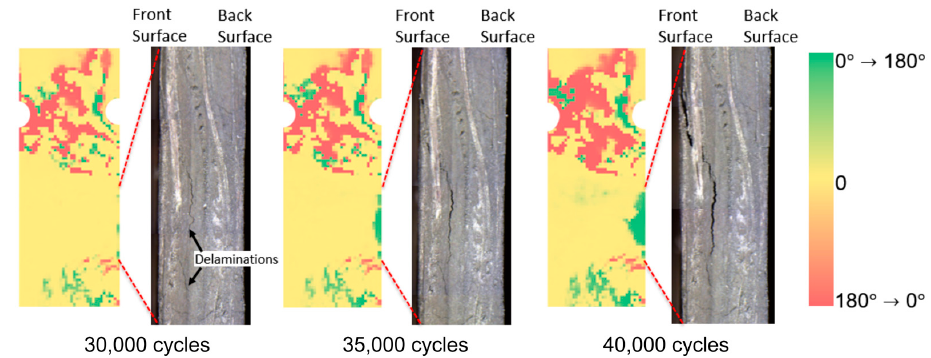
Figure 10. Microscopic visible images of specimen side surface indicating delamination damage evolution ( σ max = 180 MPa, f = 7 Hz).